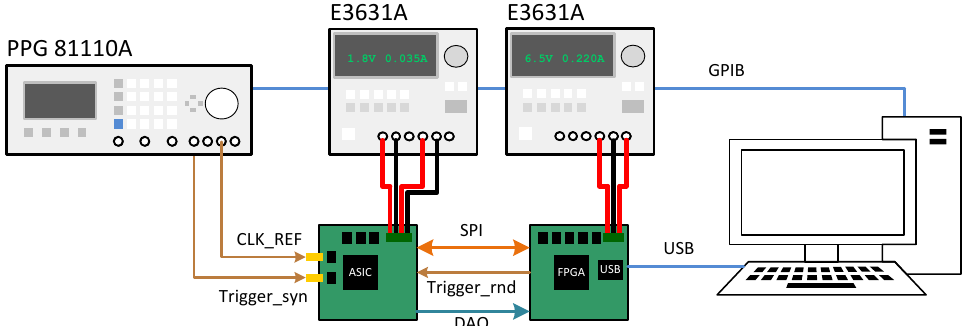
Figure 10. Schematic representation of the experimental setup used to calibrate and evaluate the jitter of the